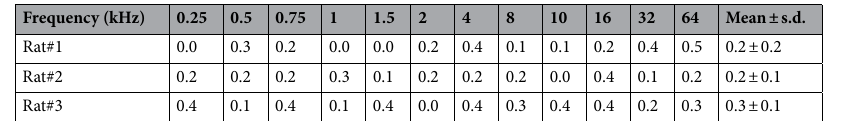
Table 1. False positive rates in